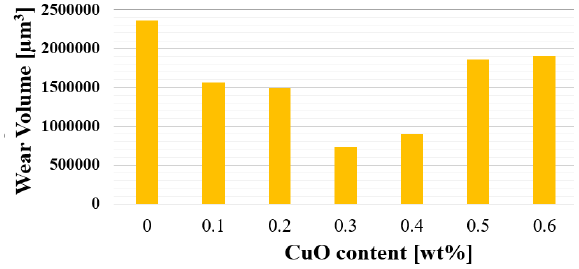
Figure 5. Comparison of the investigated lubricant samples according to the measured wear volume on the disc specimen